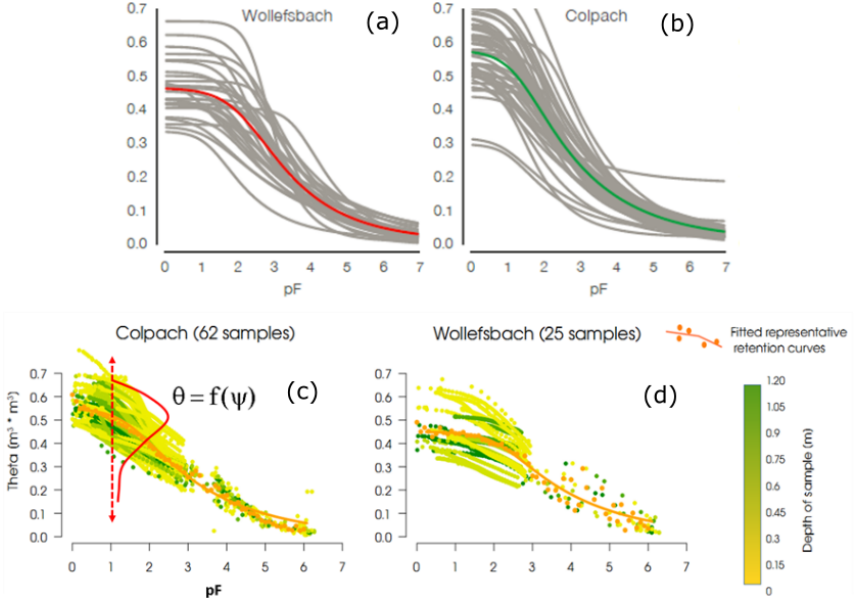
Figure 4. (a) and (b) show the retention functions Jackisch (2015) derived from individual soil cores by means of multistep outflow experi- ments. (c) and (d) illustrate the procedure of pooling the soil water contents observed at a given tension ( pF = log 10 (ψ) ) of all experiments into conditional random samples. The orange points mark the averaged θ values as a function of the tension and the solid lines are the fitted van Genuchten functions. Note that these representative curves are shown in colour in (a) and (b) as well. The colour code of the individual data points in (c) and (d) relates to the depth of the sample below the